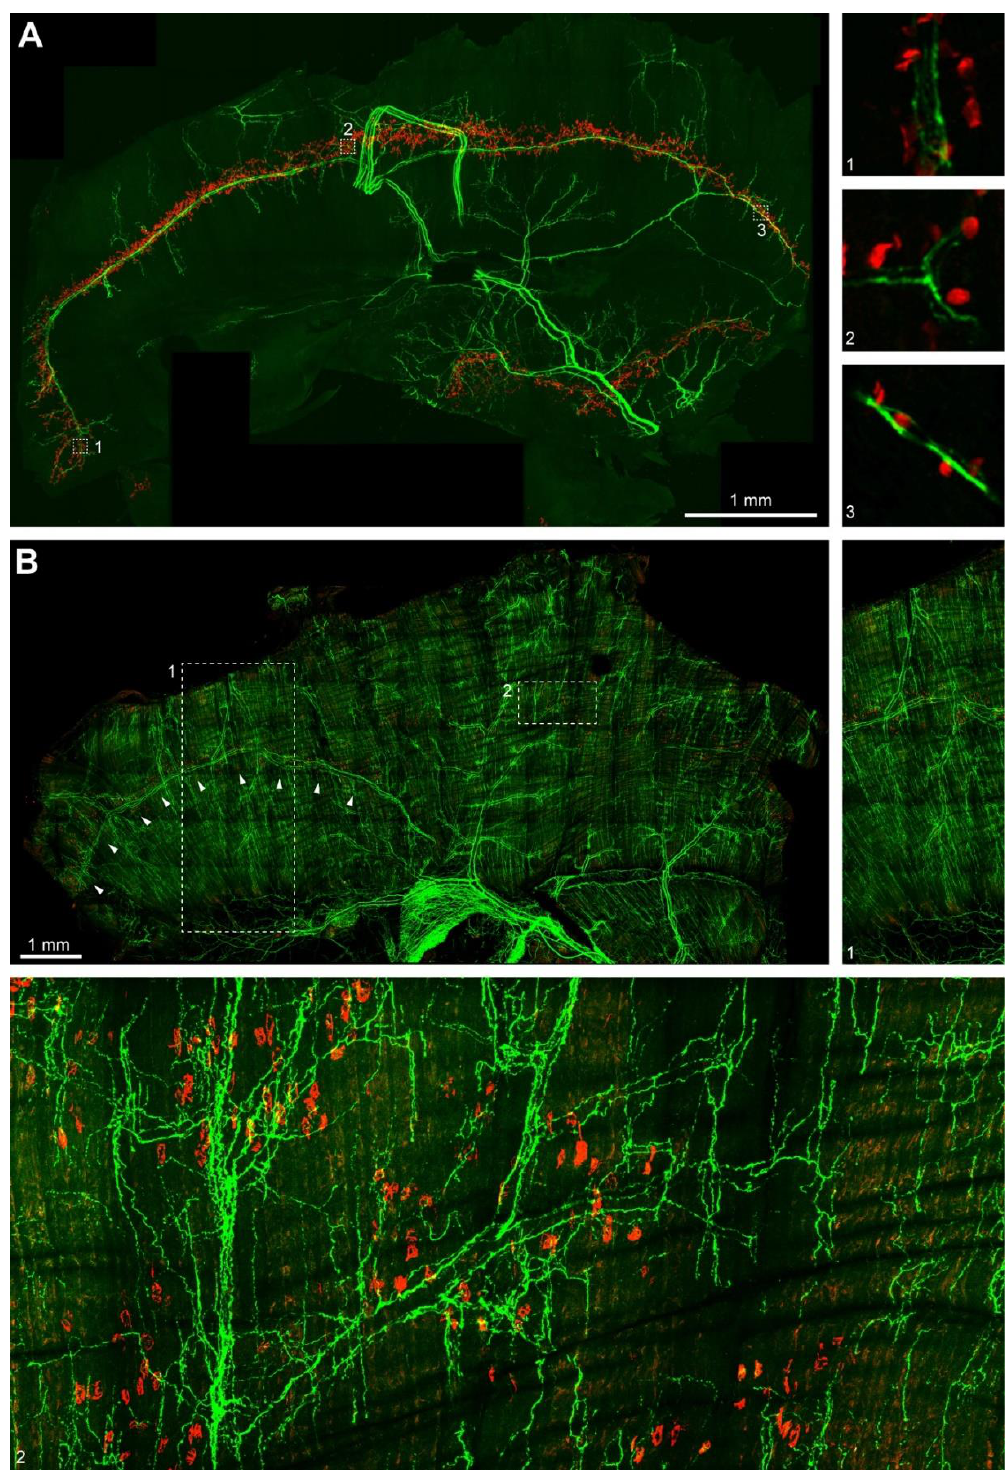
Figure 5. Sympathetic innervation of mouse diaphragm muscle gains complexity during postnatal development. Mouse diaphragm muscles from P0 ( A ) and P30 ( B ) mice were fixed, stained with BGT against NMJs (red) and antibodies against TH (green). Then, muscles were imaged by high-resolution tile scanning confocal microscopy with a lateral resolution of 758 nm and a vertical step size ranging between 1 and 1.2 µm (P0) and 7 µm (P30). Image acquisition was followed by deconvolution. Large pictures in ( A , B ) depict maximum z-projections of hemidiaphragms. Insets 1, 2, 3 show single optical sections ( A ) or enhanced details ( B ) from correspondingly numbered boxed regions in the overview images. Arrowheads in ( B ) indicate a zone, where a main branch of the phrenic artery is lined by TH label.